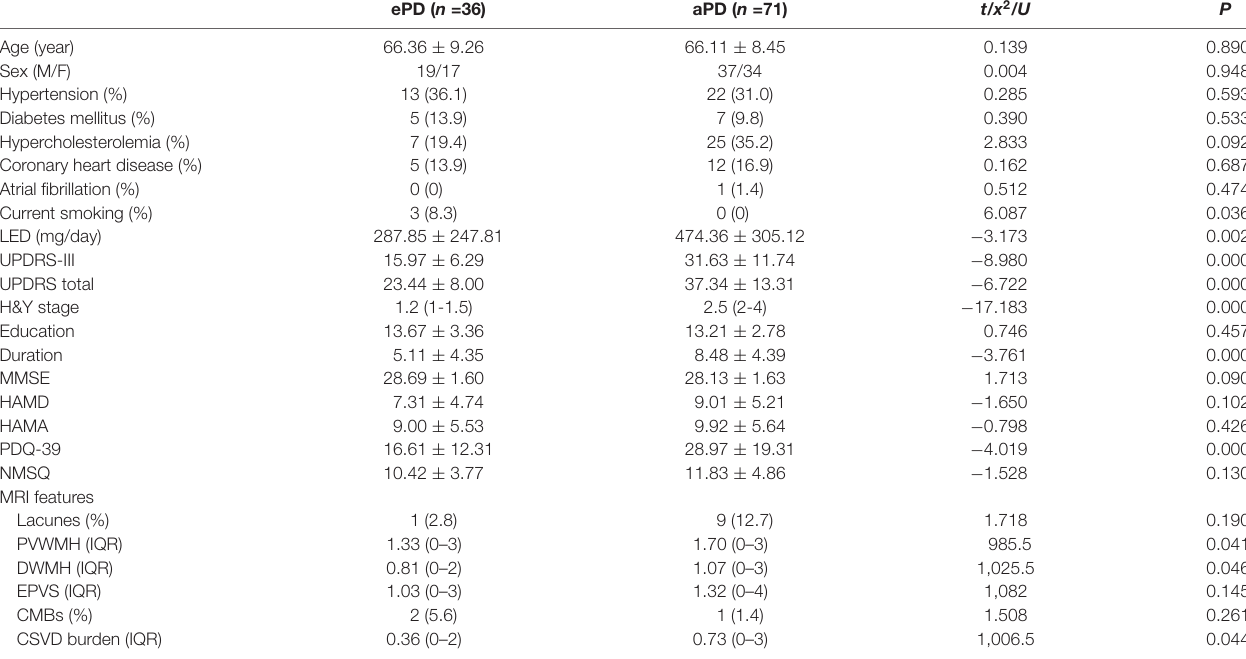
TABLE 2 | Demographic and total CSVD score in the early and advanced PD groups.